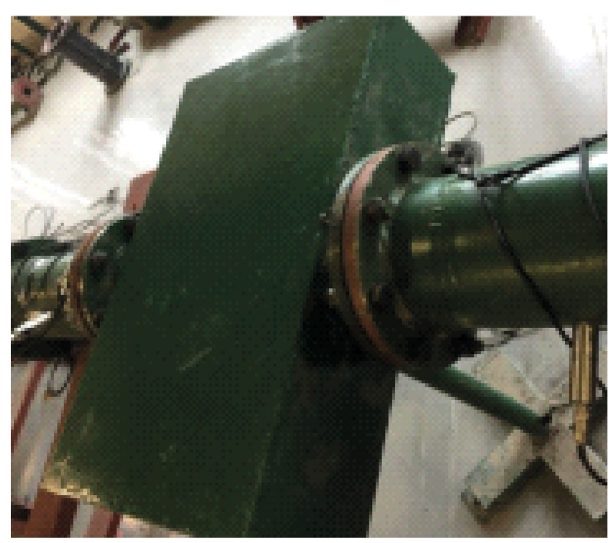
Figure 2: Photo of the